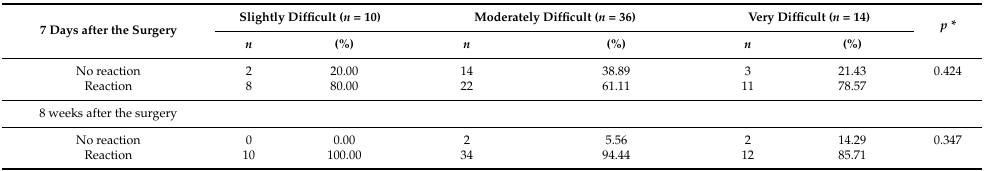
Table 8. Comparison of the relationship between the predicted difficulty of the procedure and the electrosensitivity measurement of the mandibular second molar seven days after the procedure and eight weeks after the procedure as measured by a